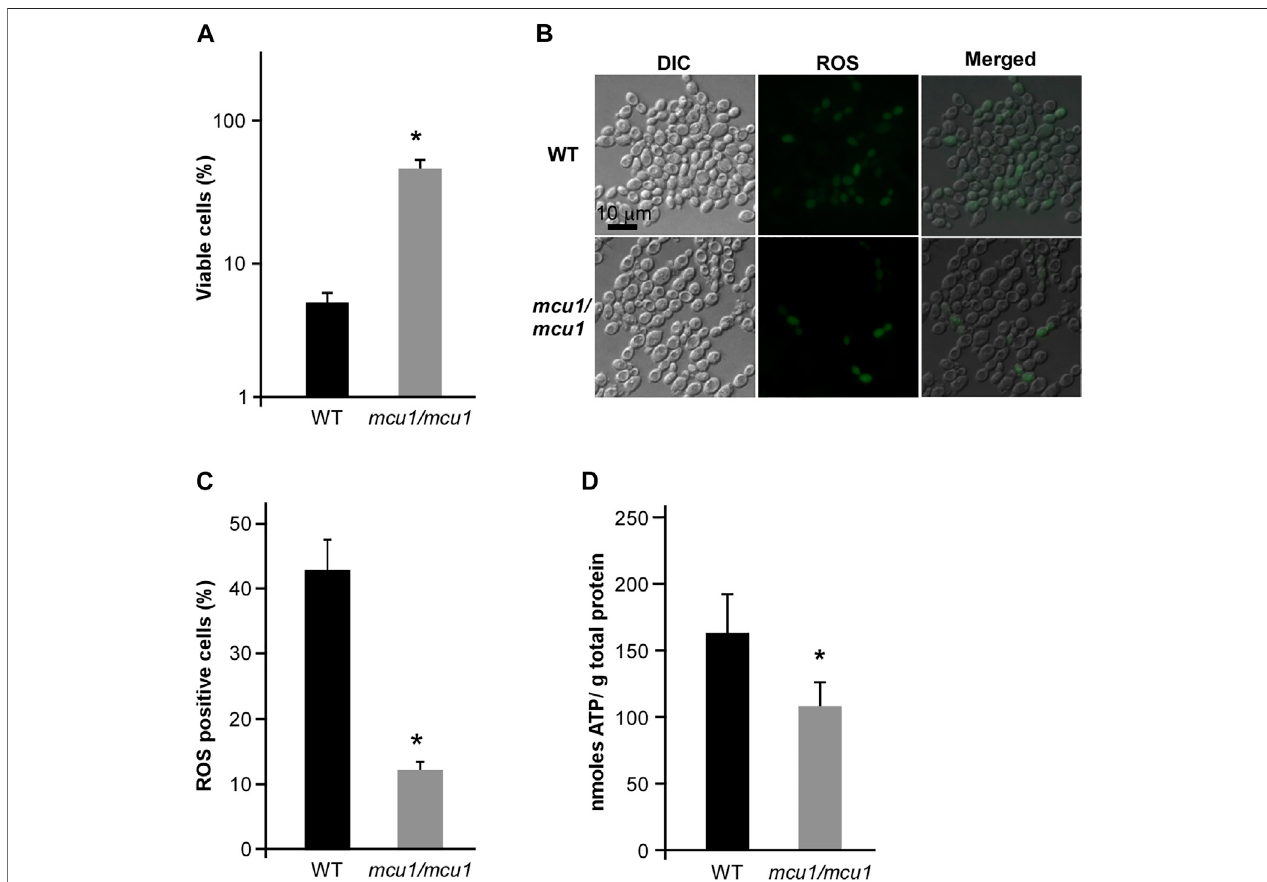
FIGURE 9 | The mitochondrial protein Mcu1 regulates CHGX water-extract-induced cell death of C. albicans . (A) The cell viability assay of WT and mcu1/mcu1 mutant strains. Fungal cells (2 × 10 5 cells/ml) were treated with 20 mg/ml CHGX water-extract in Lee ’ s glucose medium for 3 h at 30 ° C. The percentage of viable cells wasdeterminedusingplatingassays. (B) TheintracellularROSproductioninWTand mcu1/mcu1 mutantstrains.Fungalcells(2×10 6 cells/ml)weretreatedwith20 mg/ ml CHGX water-extract in Lee ’ s glucose medium for 3 h at 30 ° C. Cells were harvested and incubated with DCFH-DA for fl uorescence microscopy. (C) The percentageofROS-positivecells.Thevalueswereexpressedasmean±SDofthreeindependentexperimentsaccording fl uorescencemicroscopyassayinpanelB. (D) The intracellular ATP level of WT and mcu1/mcu1 mutant strains. Fungal cells (2 × 10 6 cells/ml) were treated with 20 mg/ml CHGX water-extract in Lee ’ s glucose medium for 2 h at 30 ° C. Cells were harvested and homogenized with 1× PBS for ATP assay by an ATP Bioluminescence Assay kit. Three biological repeats were performed, andthevaluesarepresented asmean±SD. One-wayanalysisofvariance(ANOVA)wasused tocomparedifferences betweenWTand mcu1/mcu1 mutant strains; *, p <